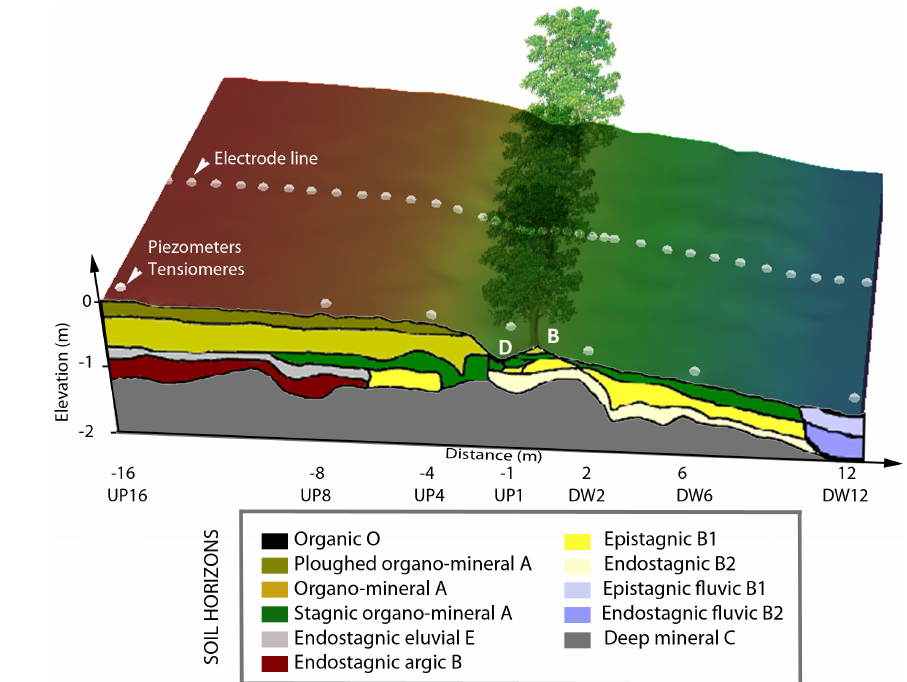
Figure 1. Experimental setup and soil horizon organization along the toposequence. Soil was excavated up from 16m upslope (UP16) to 12m downslope (DW12). Soil horizons are named according to the World Reference Base for Soil Resources (FAO, 2006). D and B indicate ditch and bank locations, respectively. Each monitored location (UP16, UP8, UP4, UP1, DW2, DW6 and DW12) was equipped with five tensiometers and one